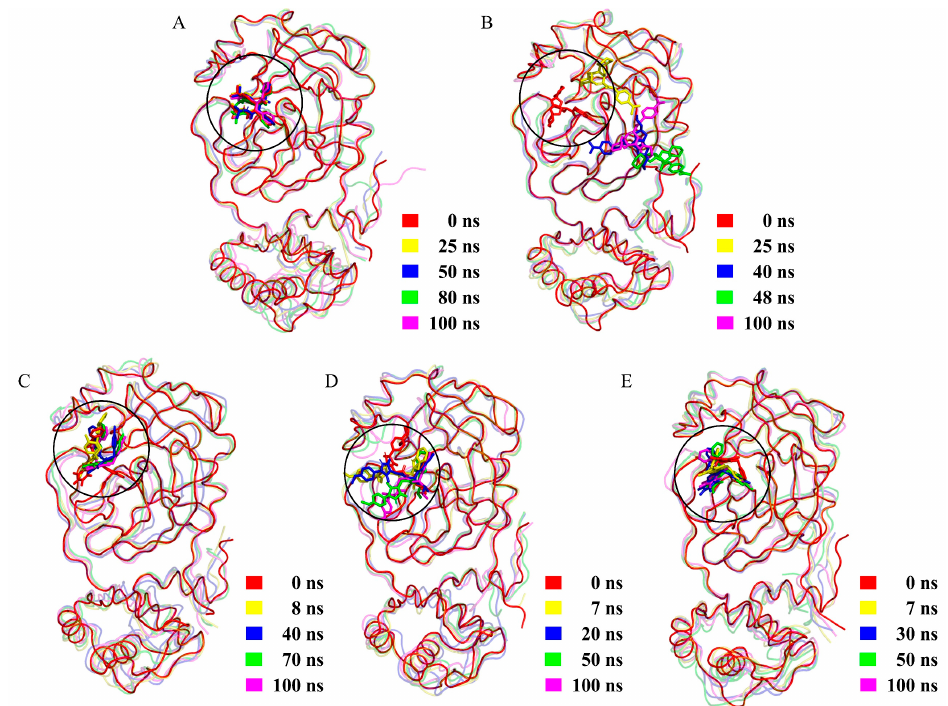
Figure 4. Structural superposition obtained by least-square fitting of the four snapshots extracted from the MD simulation trajectory at different times to the starting structure. ( A ) Mpro-ML188. ( B ) Mpro-ECI1. ( C ) Mpro-ECI2. ( D ) Mpro-ECI3. ( E ) Mpro-ECI4. Mpro and ML188/ECIs are shown in tube and stick representations, respectively, with the substrate-binding site highlighted by a circle. For convenience of observation, in all complexes, the Mpro structure at 0 ns (starting structure) is represented as an opaque tube while those at the other times as a semi-transparent tube.